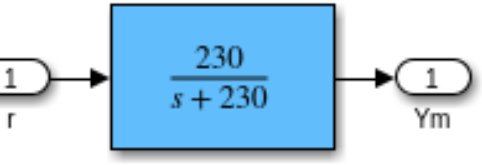
Figure 6. Model reference Simulink block .